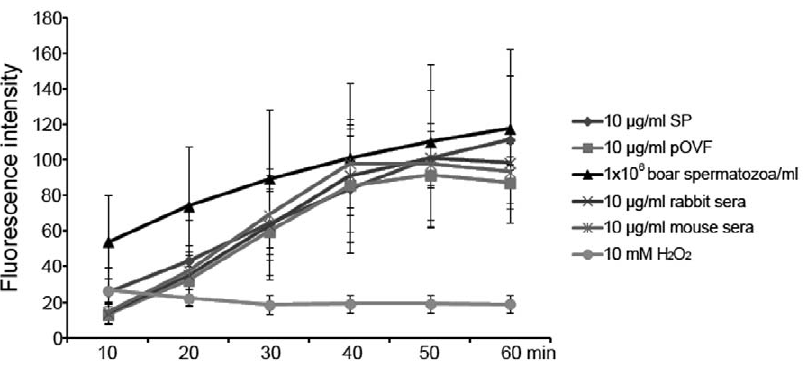
Figure 3. Measurement of pyrophosphate (PPi) content by fluorometric assay. PPi assay with boar seminal plasma (SP), porcine oviductal fluids (pOVF), rabbit sera, mouse sera (final conc. 10 m g/ml), boar spermatozoa (1 6 10 6 spermatozoa/ml) and 10 mM H 2 O 2 working solution (a negative control). The emitted fluorescence (no units) was measured at multiple time points to follow the kinetics of the reaction (excitation 530 nm; emission 590 nm). Experiments were repeated three times. Values are expressed as the mean of fluorescence intensity 6